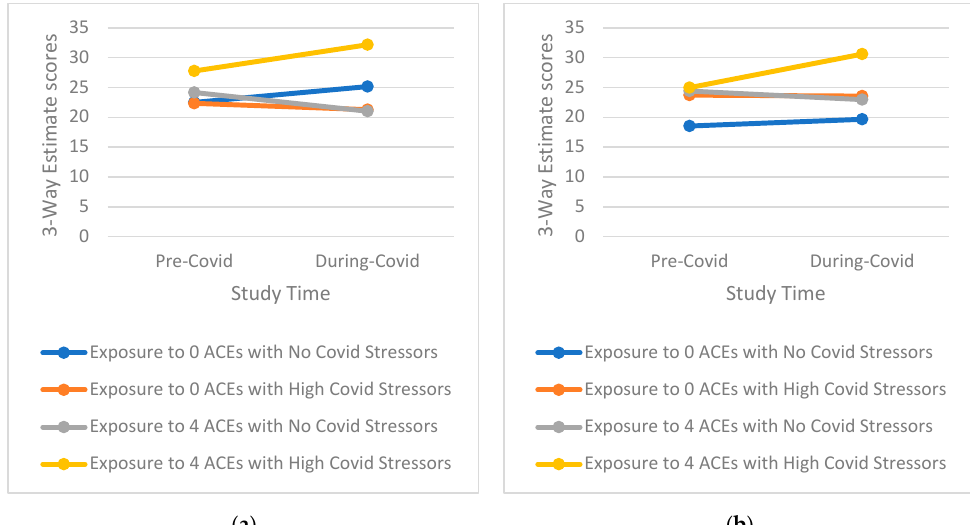
Figure 2. ( a ) Interaction of greater exposure to ACEs and high levels of Loneliness on Changes in Anxiety Symptomatology among Young Adults from Before to During the COVID-19 Pandemic; ( b ) Interaction of greater exposure to ACEs and high levels of Suspiciousness on Changes in Anxiety Symptomatology among Young Adults from Before to During the COVID-19 Pandemic.